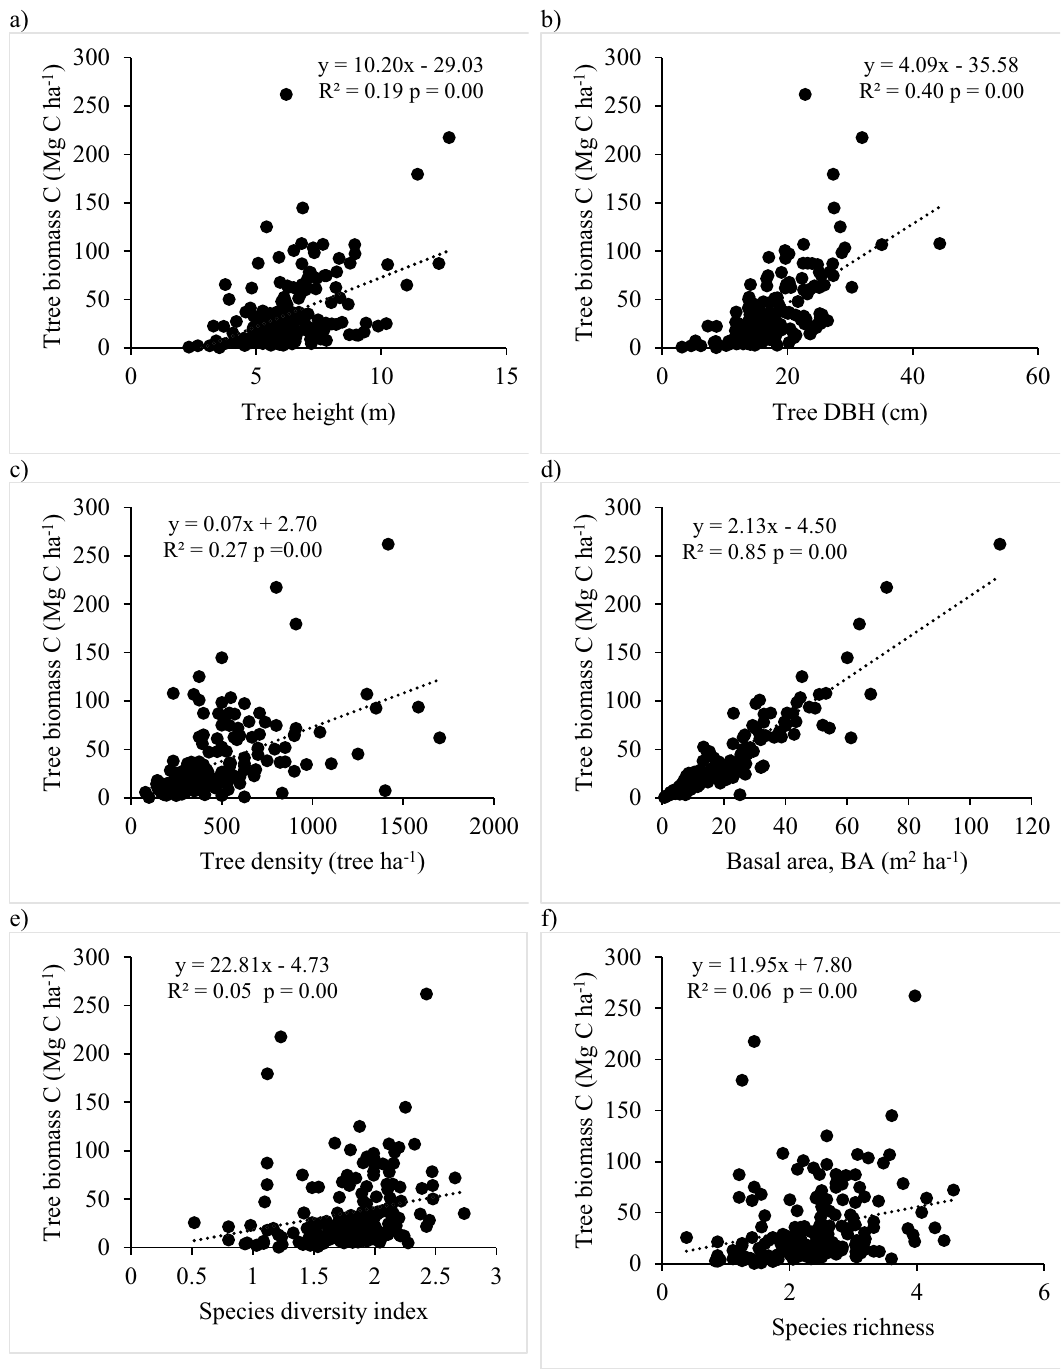
Figure 2. Relationship of tree biomass carbon (C) stocks with ( a ) tree height, ( b ) DBH, ( c ) density, ( d ) BA, ( e ) species diversity, and ( f ) richness in the homestead forests across three